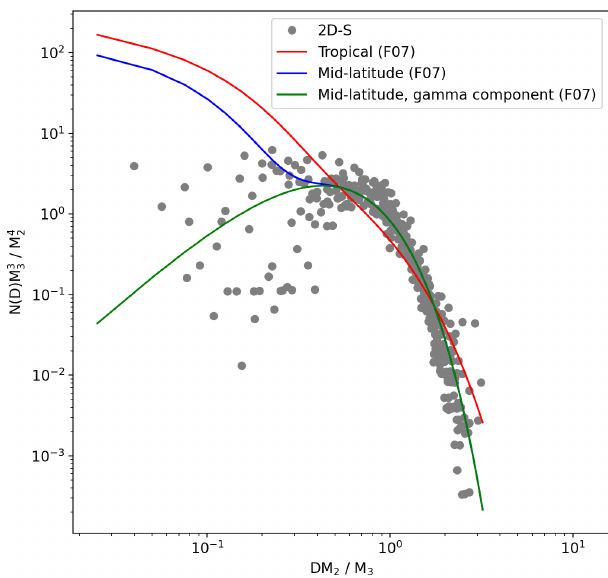
Figure 19. Comparison between 2D-S size distributions of co- located particles from a research flight in cirrus on 11 March 2015 and Field et al. (2007) parameterisations for tropical and mid- latitude ice